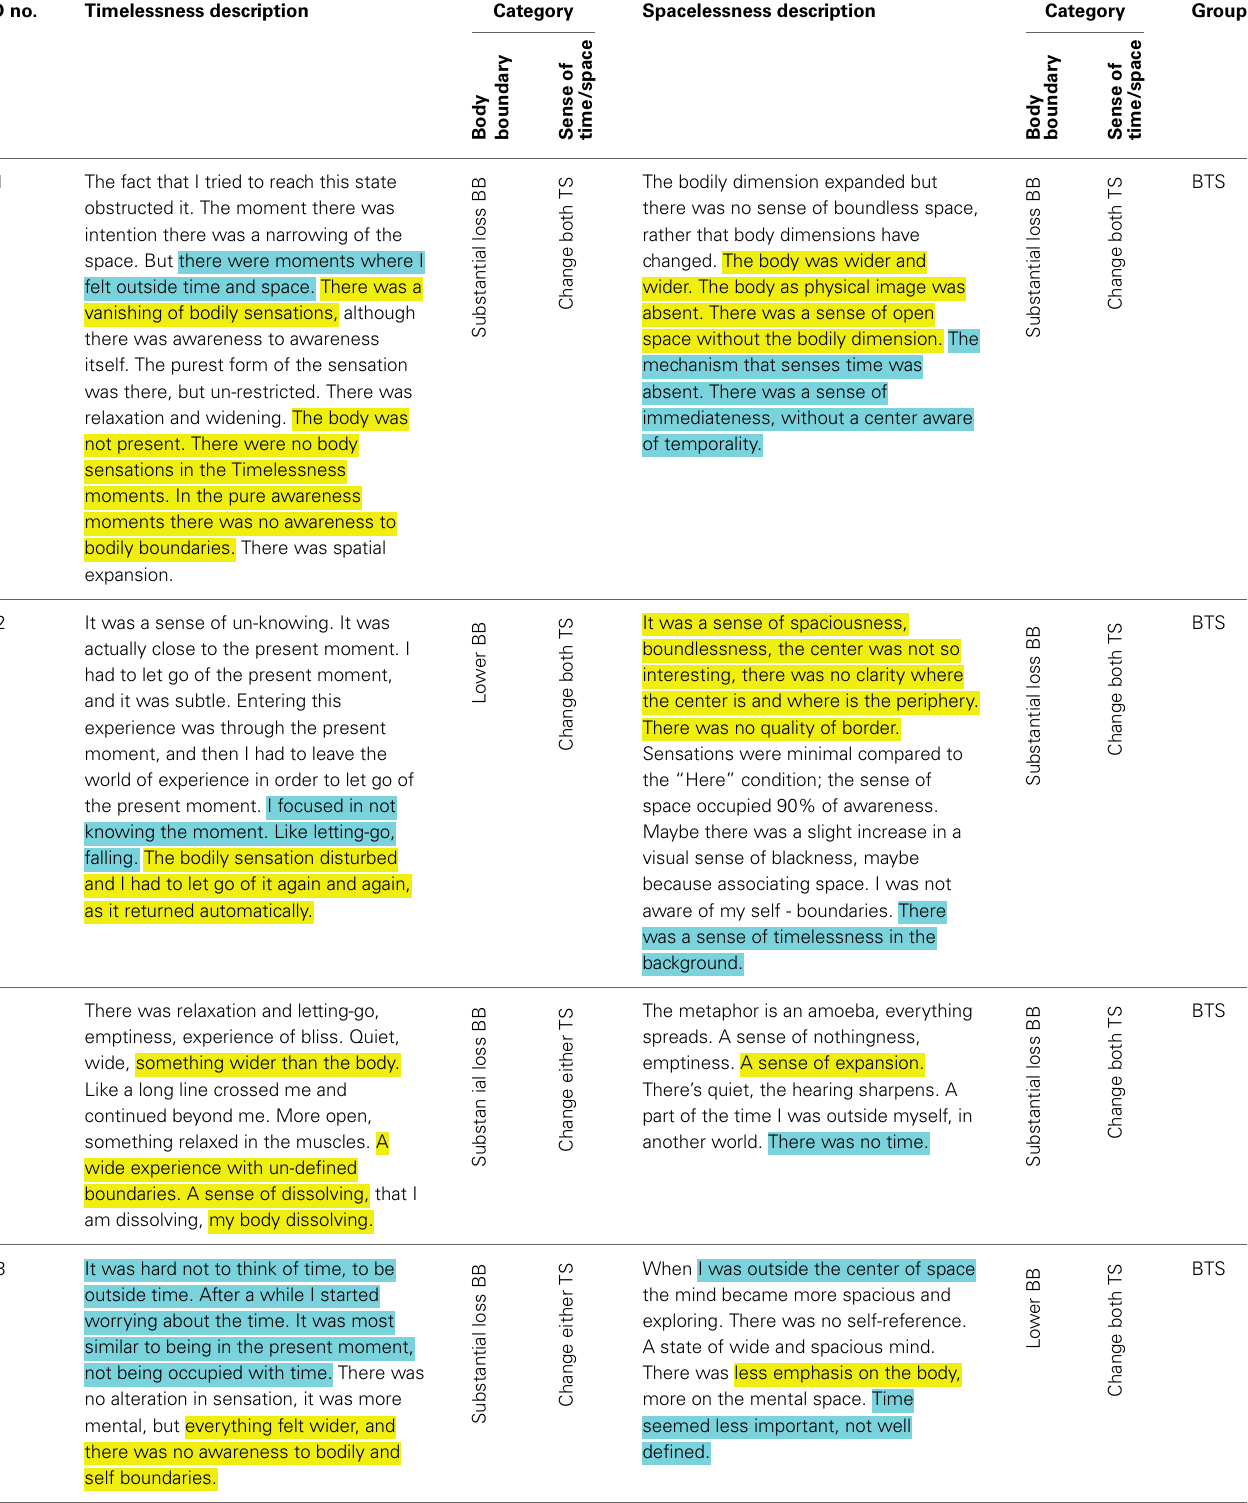
Table 1 | Classification of participants to phenomenological categories and groups. ID